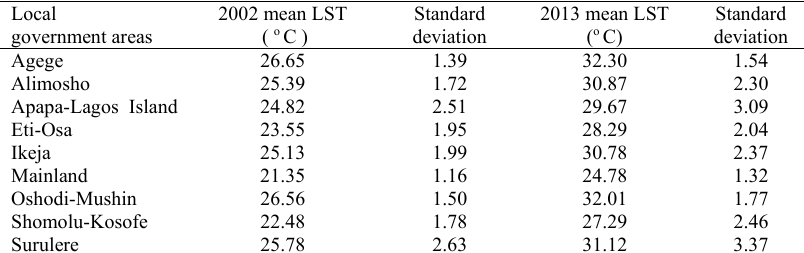
Table 4: The mean LST for each of the local government areas (2002 and 2013) Local government areas